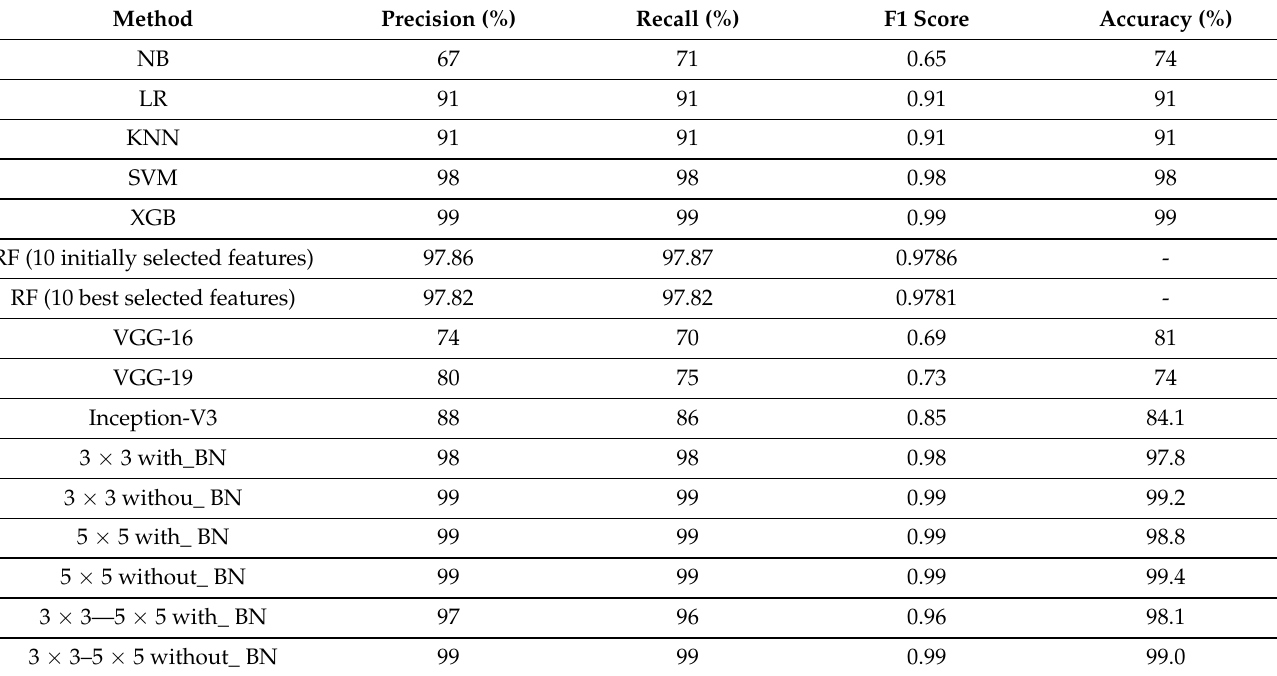
Table 7. Comparison of the proposed method with previous work on SDN datasets for 10-IoT